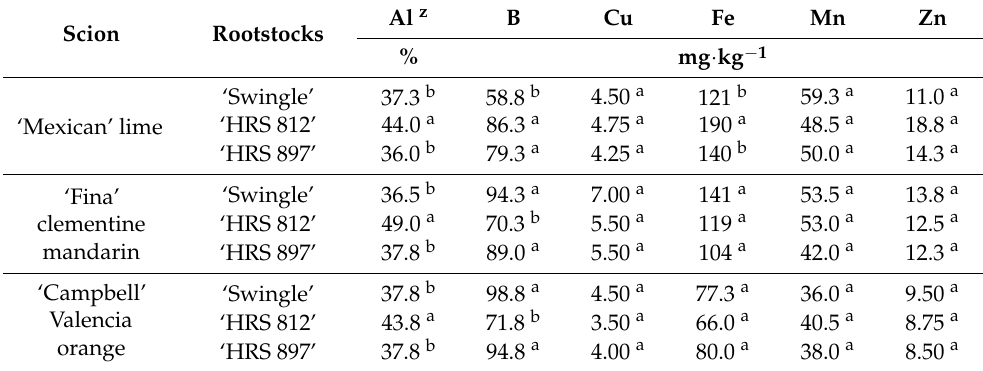
Table 3. Mean concentrations of plant micronutrients and trace elements in 2021 of three citrus cultivars grafted in three different rootstocks and growing under fertigation practices on Coto series soil at the Agricultural Experiment Station of Isabela, Puerto